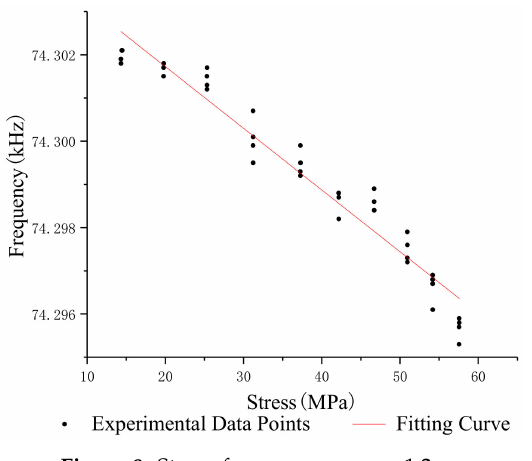
Figure 8. Stress-frequency curve—1.2 m.